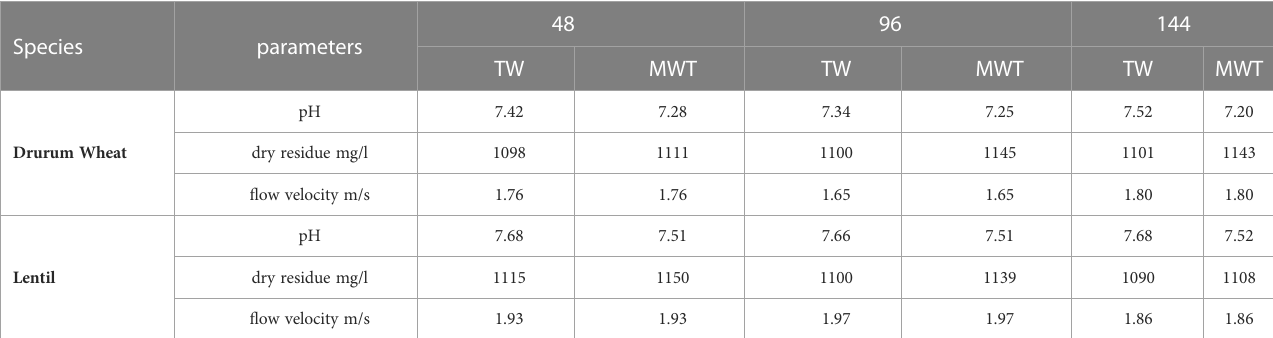
TABLE 1 Water properties before and after magnetic treatment.